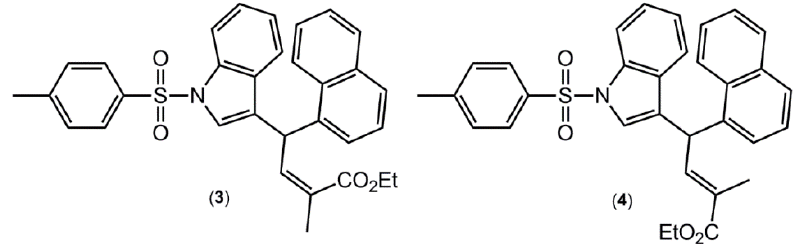
Figure 4. Chemical structures of ethyl 2-methyl-4-(1-((4-methylphenyl)sulfonyl)-1H- indol-3-yl)-4-(1-naphthyl)but-2-enoate ( 3 ), the Z -conformer with Z ' = 1, and 4 , the E -conformer with Z ' =